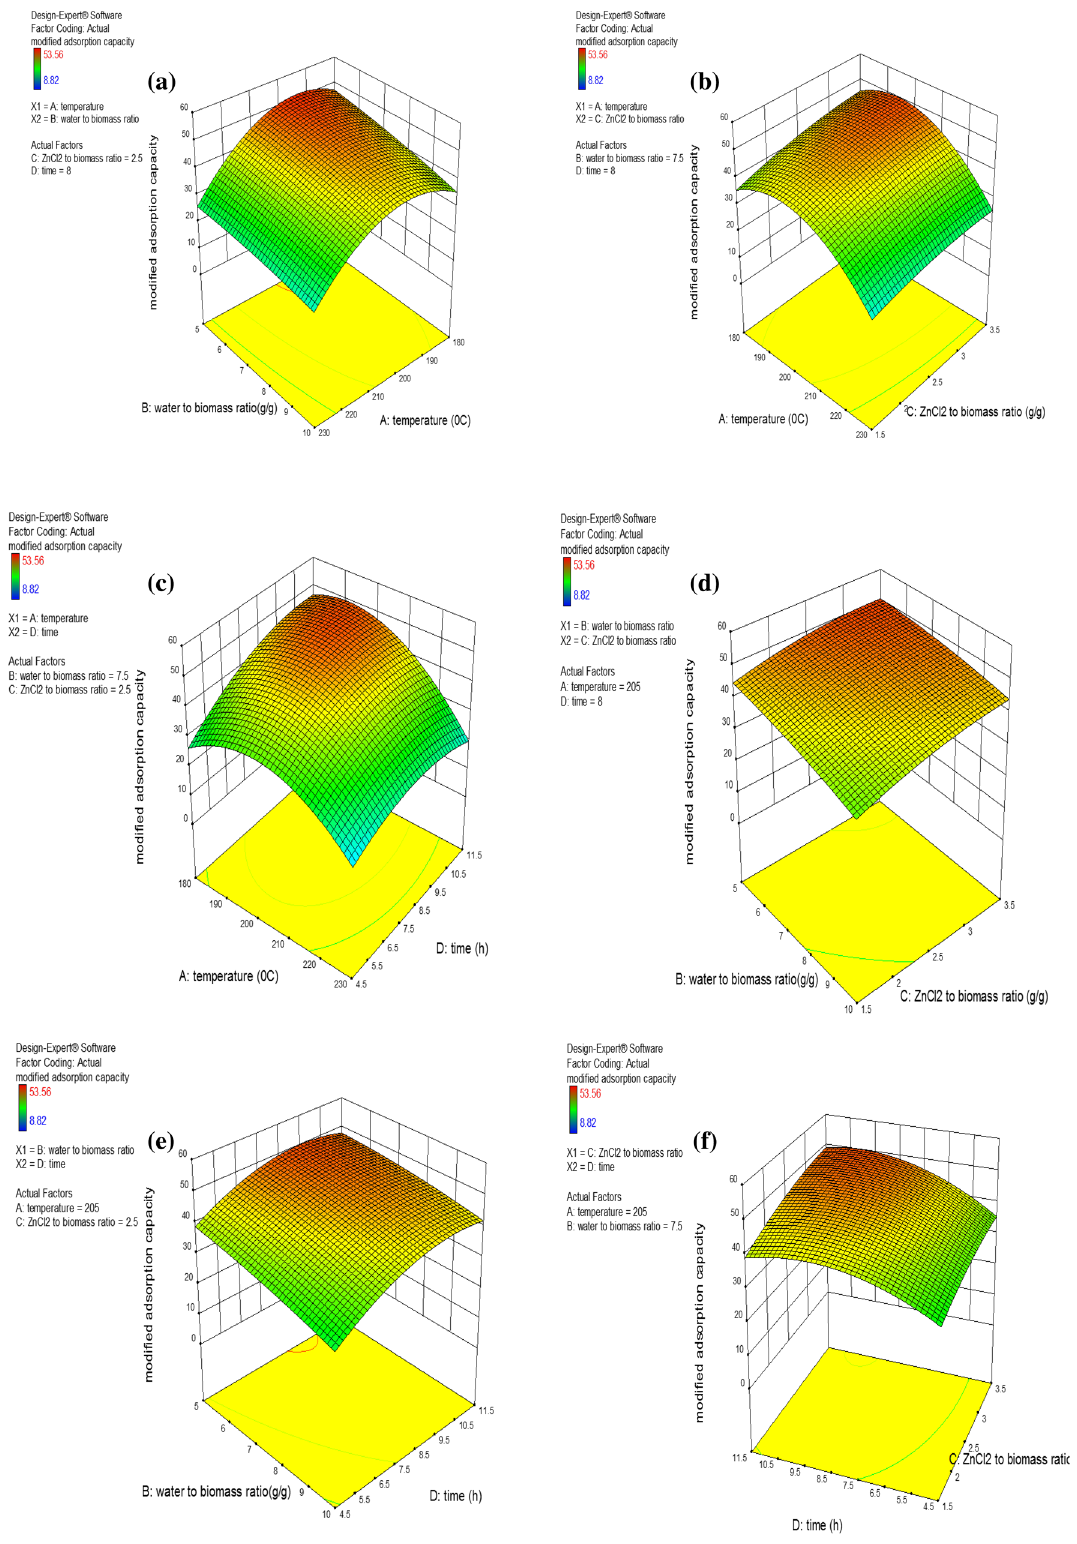
Figure 2. Three-dimensional response surface for MAC: water to biomass ratio versus temperature ( a ), temperature versus ZnCl 2 to biomass ratio ( b ), temperature to time ratio ( c ), water to biomass ratio versus ZnCl 2 to biomass ratio ( d ), water to biomass ratio versus time ( e ) and time to ZnCl 2 to biomass ratio ( f